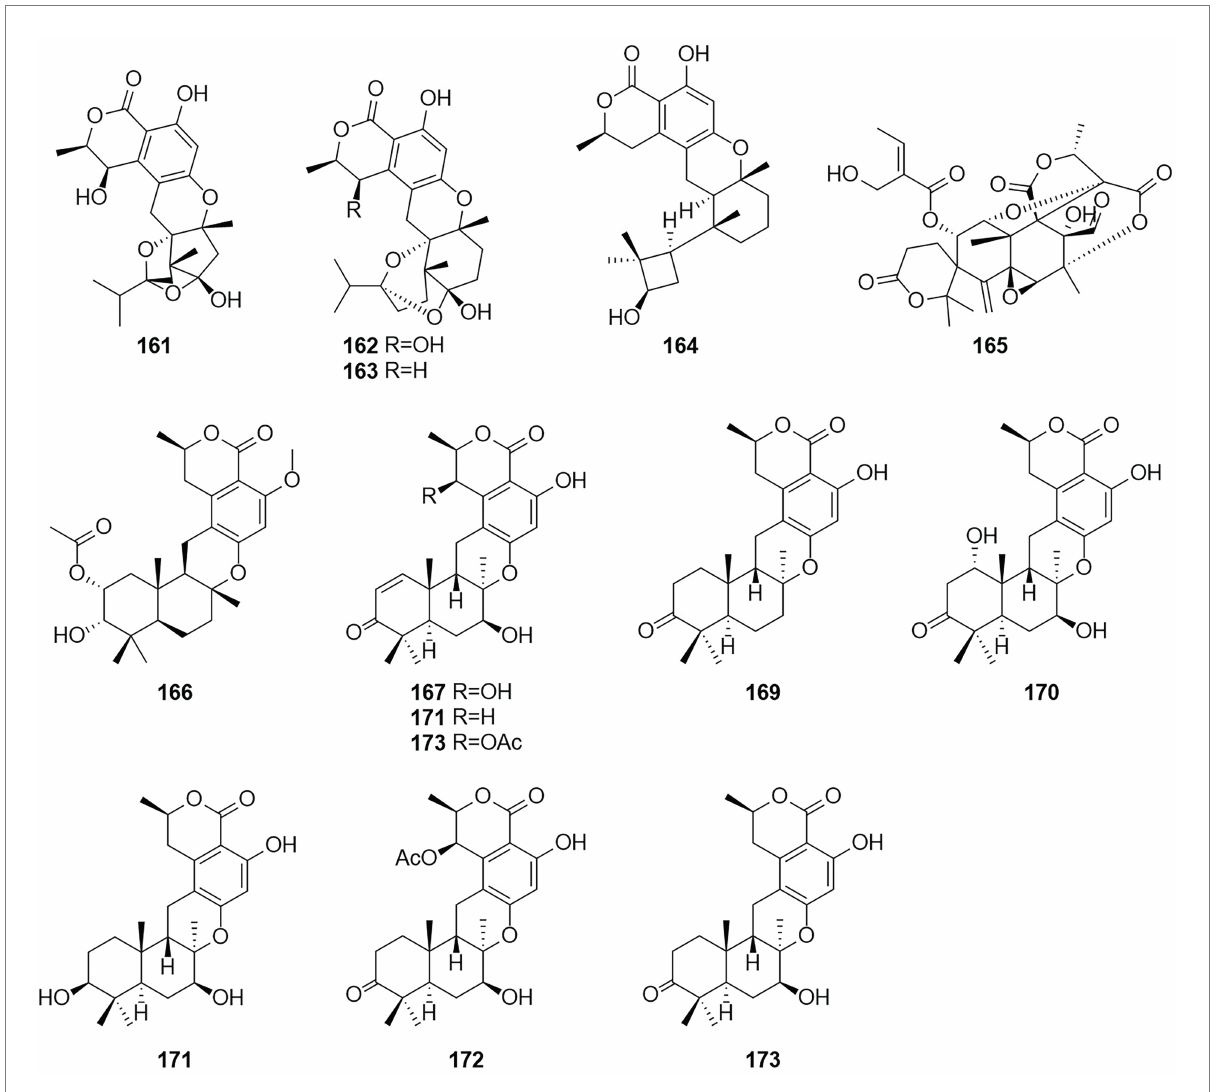
FIGURE 10 Chemical structures of compounds 161–173